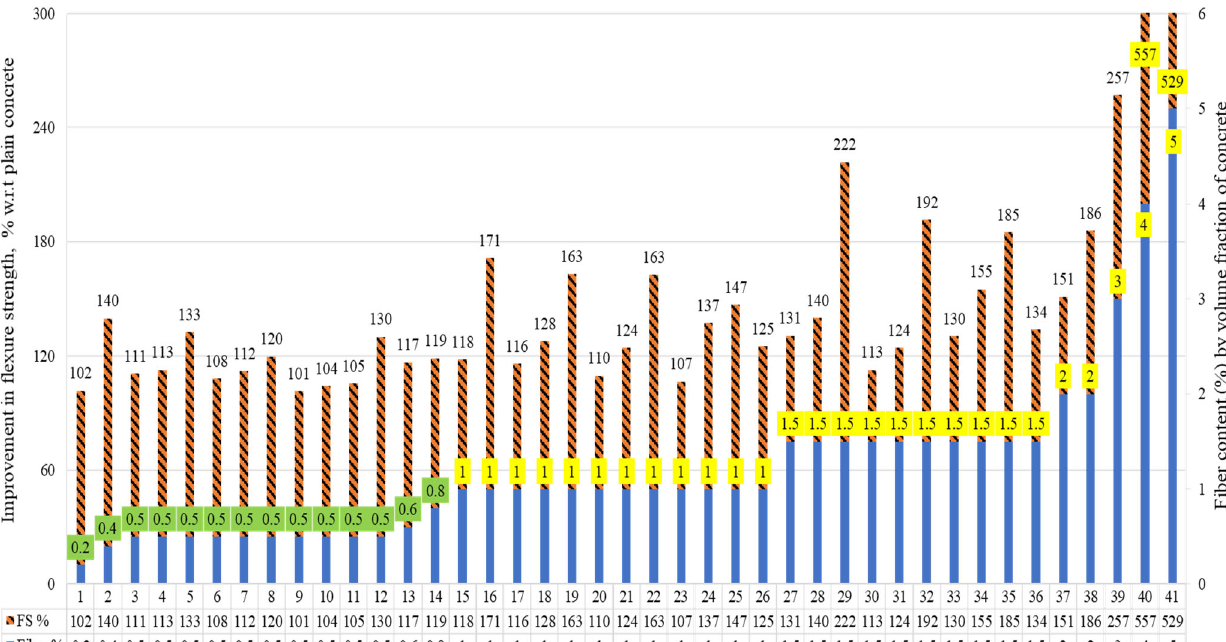
Figure 12. Percentage comparison of the flexure strength of concrete containing RSF by volume fraction.